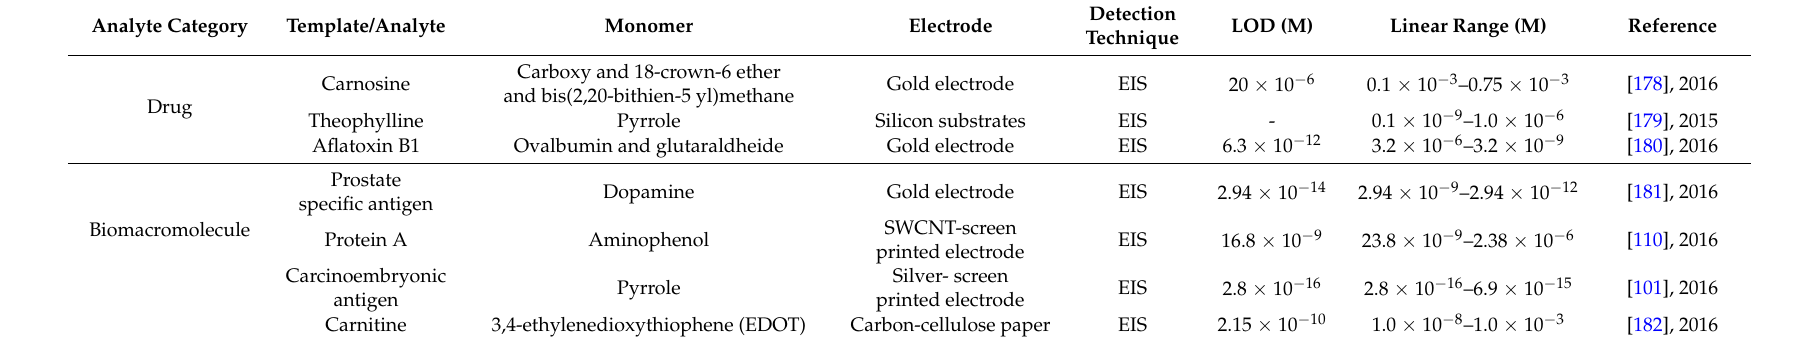
Table 3. Impedimetric/Capacitive transduction for MIP based electrochemical sensors